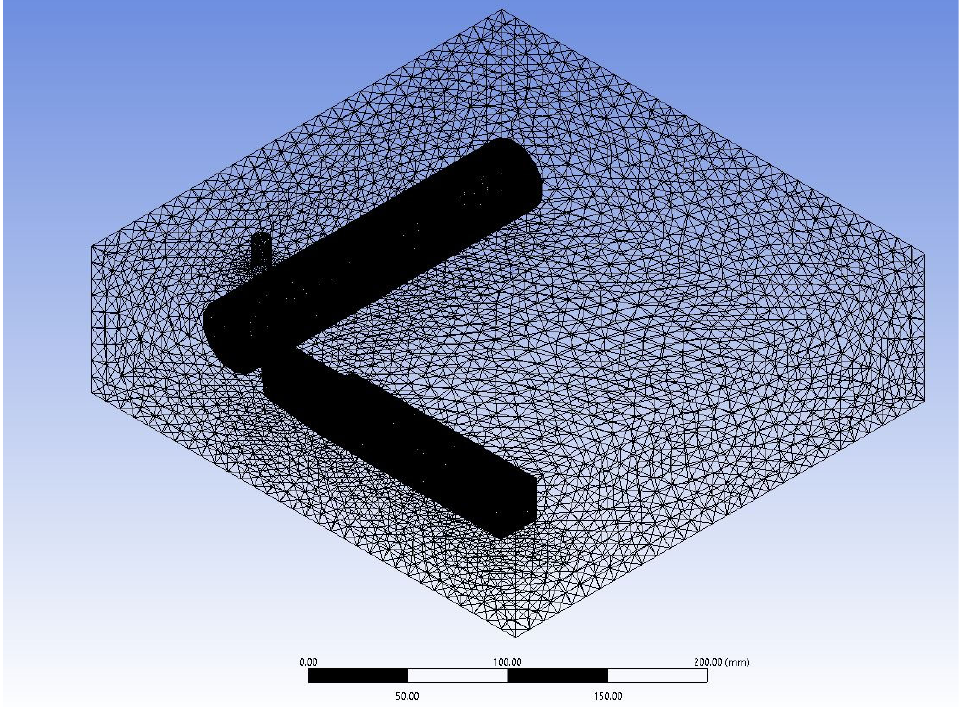
Figure 3. Meshed computational domain with a mesh count of 4.39 million cells and an element size of 5 mm.